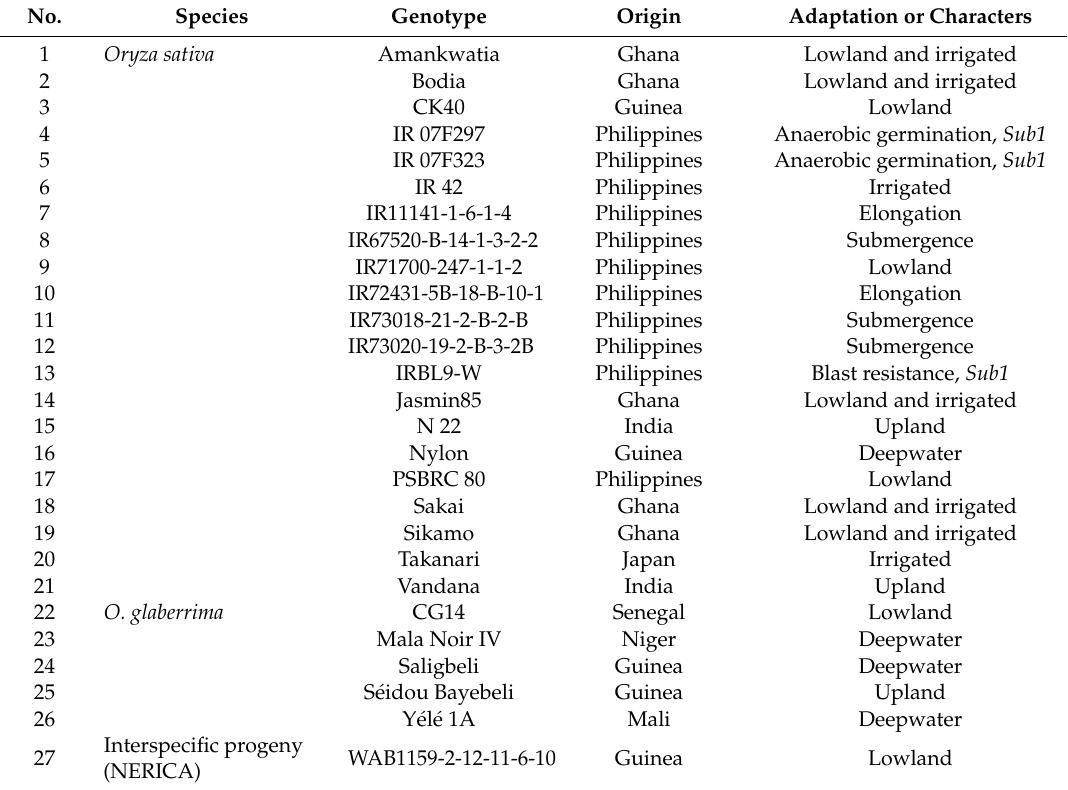
Table 1. List of 27